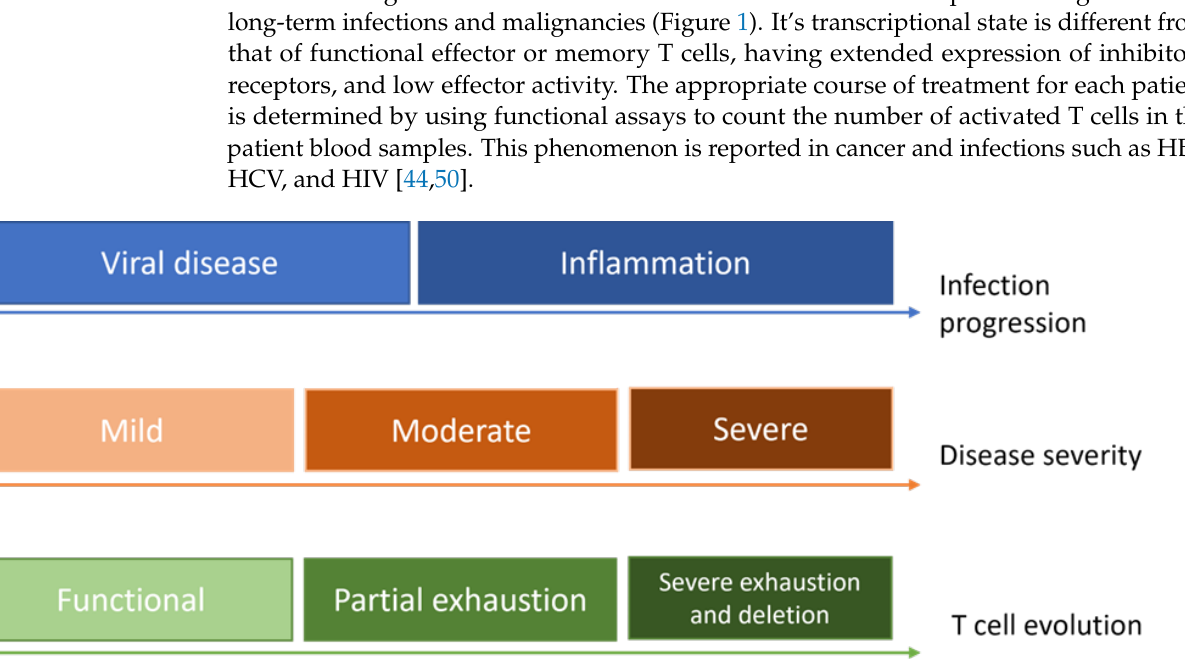
Figure 1. Simplistic demonstration of T cell evolution according to infection progression and disease severity. ease severity.